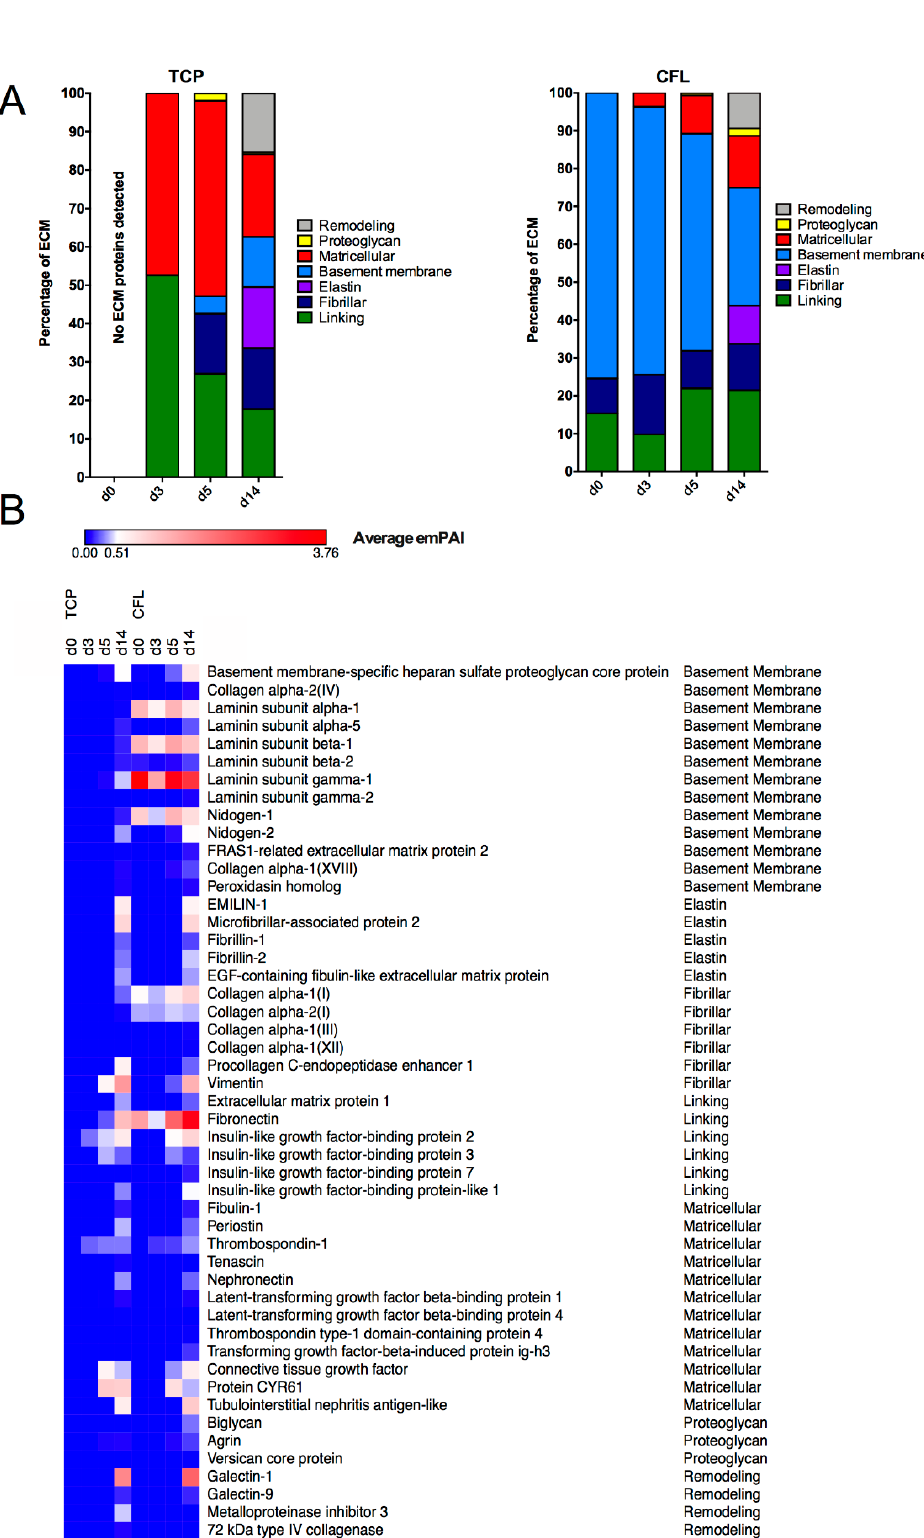
Figure 3. Dynamic changes of ECM proteins composition in miPSC cultures following ECM-driven cardiomyocyte differentiation. ( A ) Proteomic analysis of ECM families in TCP or CFL cultures at days 0, 3, 5, and 14 that was based on the emPAI number, determined with LC–MS 2 . ( B ) Heatmap of all identified ECM proteins based on the average emPAI number to estimate the level of proteins in samples.